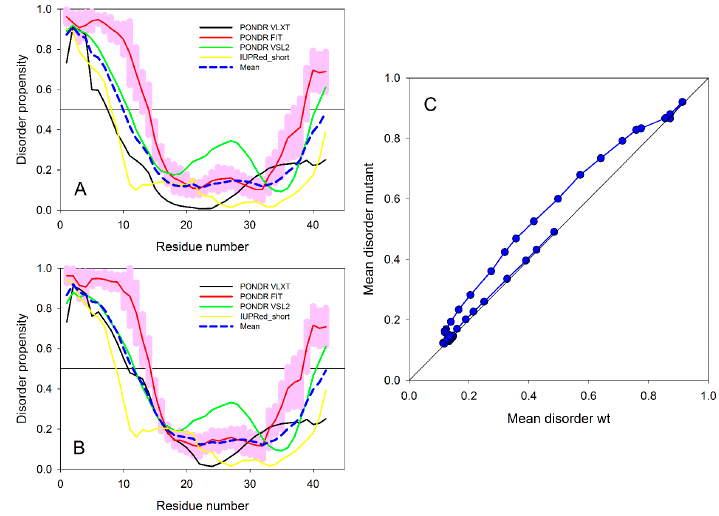
Figure 5. Analysis of the effects of the Tyr10Ala mutation on the intrinsic disorder propensity of human A β 42 was evaluated using several common disorder predictors, including PONDR FIT, PONDR VLXT, PONDR VSL2 and IUPred. Scores above 0.5 are considered to correspond to disordered residues/regions. ( A , B ) Results of this multiparametric computational analysis of intrinsic disorder predisposition for ( A ) WT A β 42 and ( B ) the Tyr10Ala mutant; ( C ) Per-residue mean disorder propensity calculated for the Tyr10Ala mutant vs. the per-residue mean disorder propensity calculated for WT A β 42 .